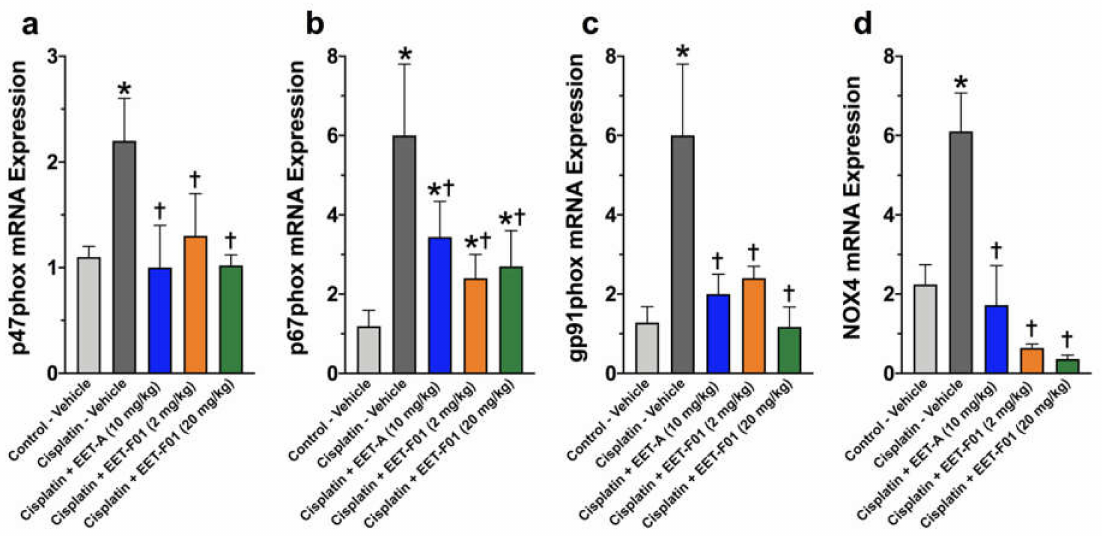
Figure 4. Renal oxidative stress in cisplatin nephrotoxicity is reduced by EET-F01 and EET-A treatments. RT-PCR analysis for mRNA expressions of ( a ) p47phox, ( b ) p67phox, ( c ) gp91phox, ( d ) NOX4. * p < 0.05 vs. control–vehicle group; † p < 0.05 vs. cisplatin–vehicle group. Data expressed as mean ± SEM, n = 6/group.